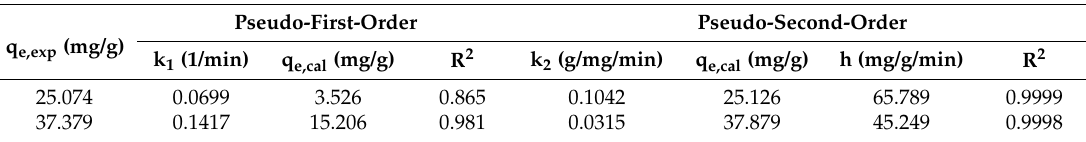
Table 3. Kinetic parameters for the adsorption of BPA by